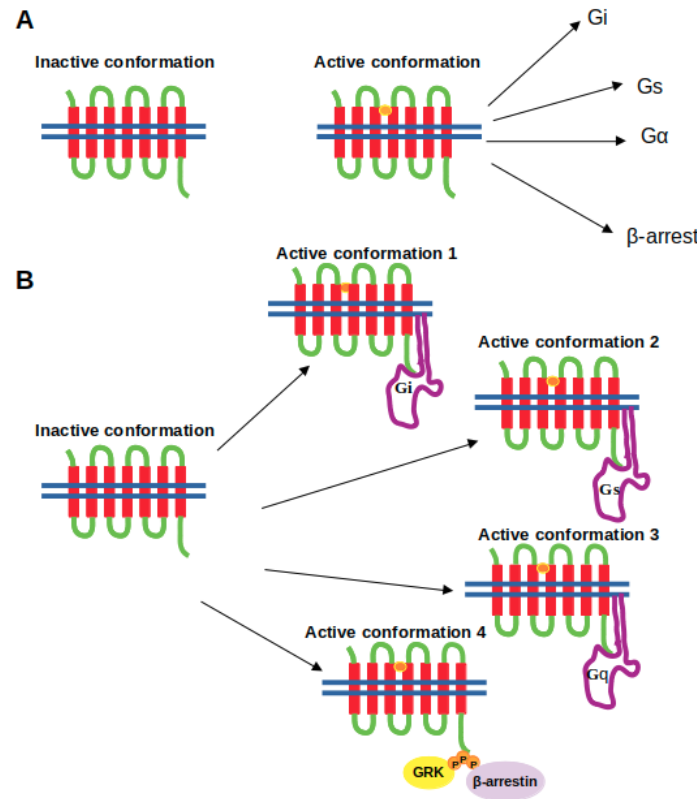
Figure 1. Depiction of the ( A ) the two-state model and ( B ) the “new-model” proposed for GPCR activation. The ligand is shown in the orange circle, whereas the boundary of the cell membrane is shown by blue